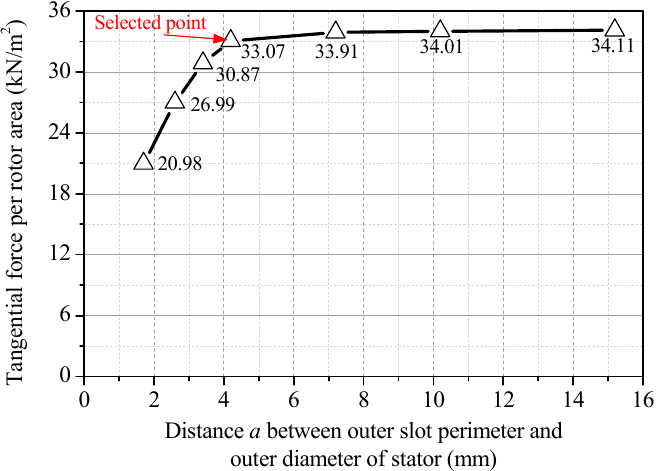
Figure 6. Tangential force density versus the distance a between the outer slot perimeter and the outer diameter of the stator.